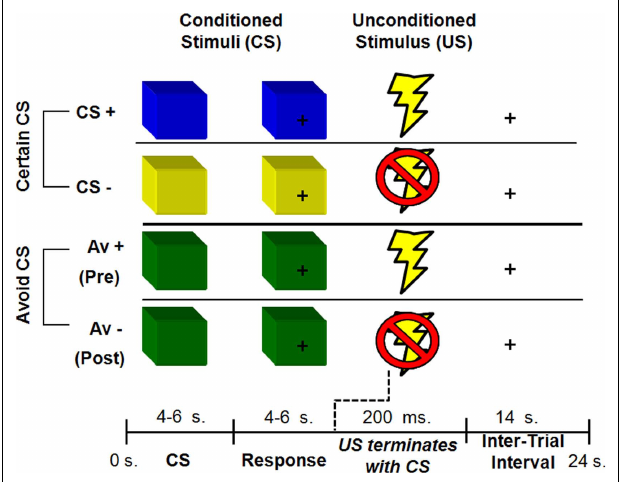
FIGURE 1 | Human avoidance paradigm. Participants were presented with three types of CS. Both CS + and CS − predicted a certain outcome (an aversive shock or no shock respectively). The AV + condition predicted a potential shock but afforded the participant an opportunity to avoid a shock with the